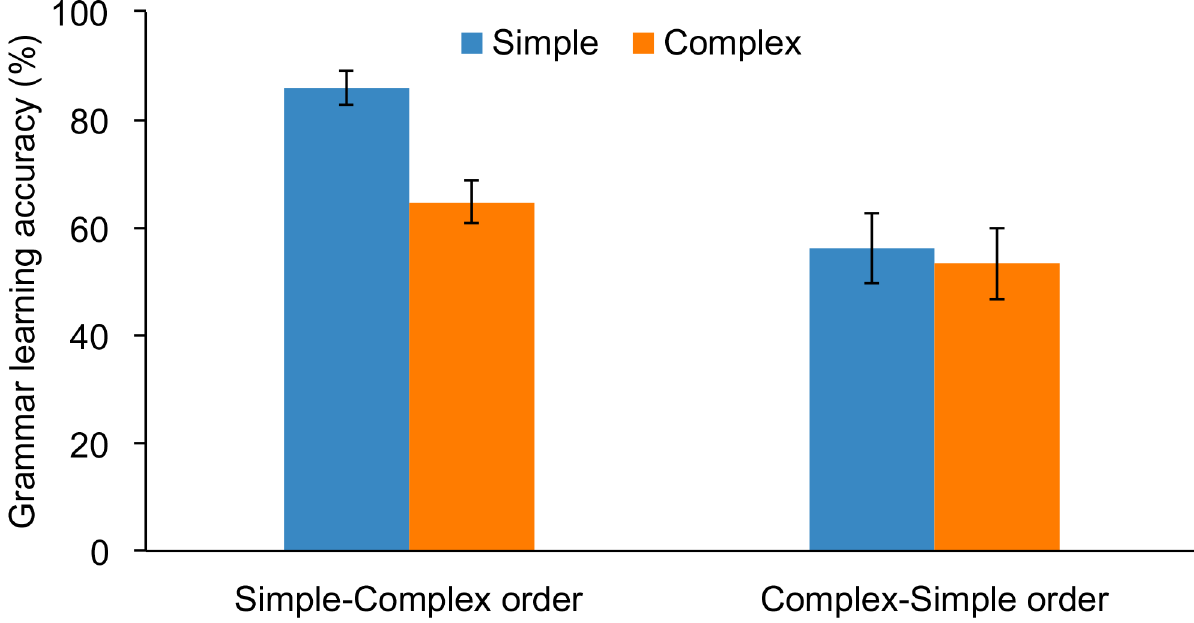
Fig 5. Grammar learning accuracy (%) of simple and complex grammar rules by subjects who underwent simple-complex or complex-simple training orders. Error bars depict standard error of the mean.